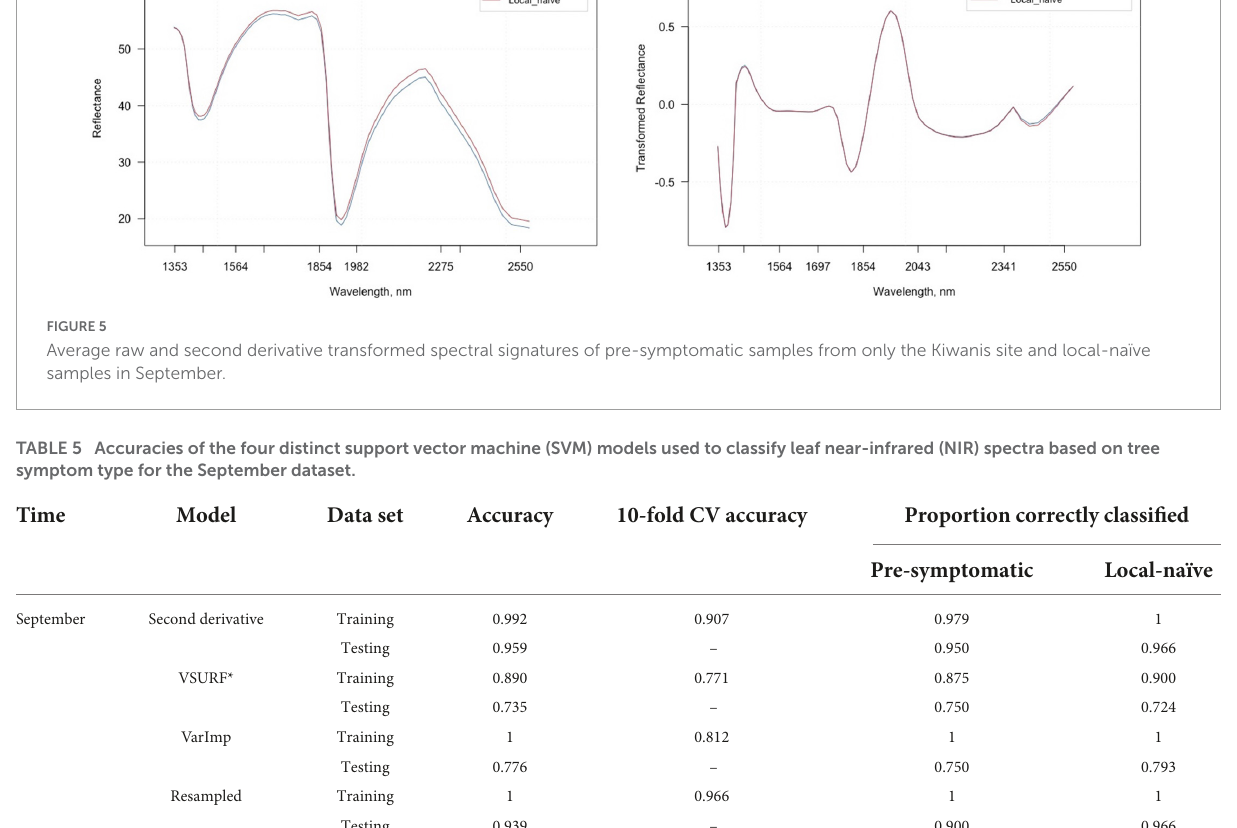
Pre-symptomatic Local-naïve